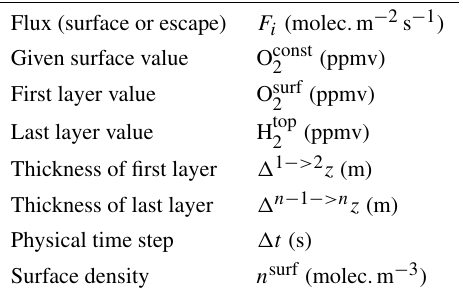
Table 1. Terms used in Eqs. (1)–(3).